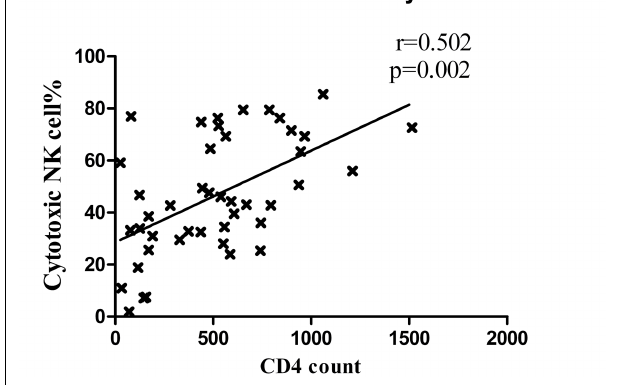
FIGURE 4 |Association between CD4 cell count and cytotoxic NK cells . The CD4T cell counts of patients with recent HIV infection are plotted on X axis and the percentage of cytotoxic NK cells was plotted on Y